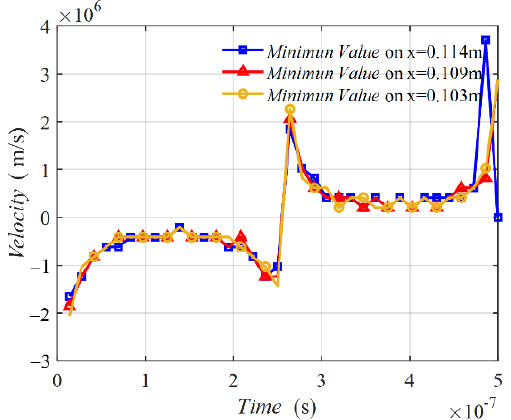
Figure 10. Velocity on three middle lines varying with time.